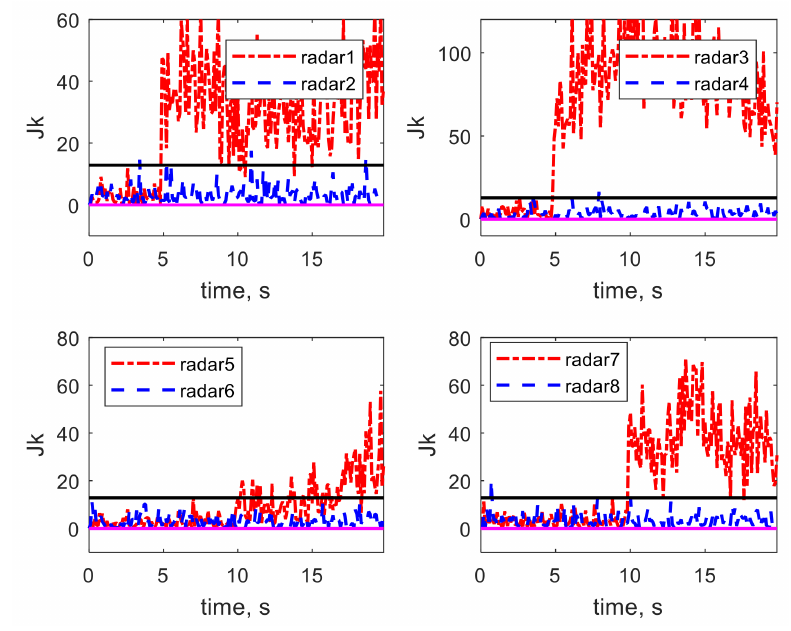
Figure 6. Injected data detection results.